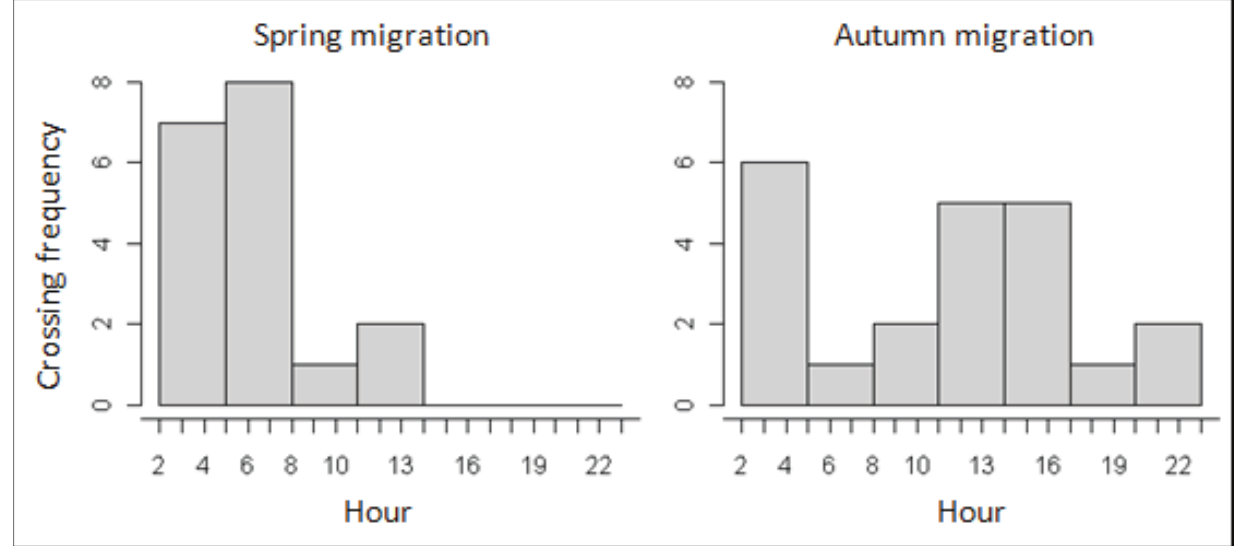
Fig. 3. Reindeer crossing frequency of road Rv 45 in Setesdal Austhei with respect to time of day during spring and autumn